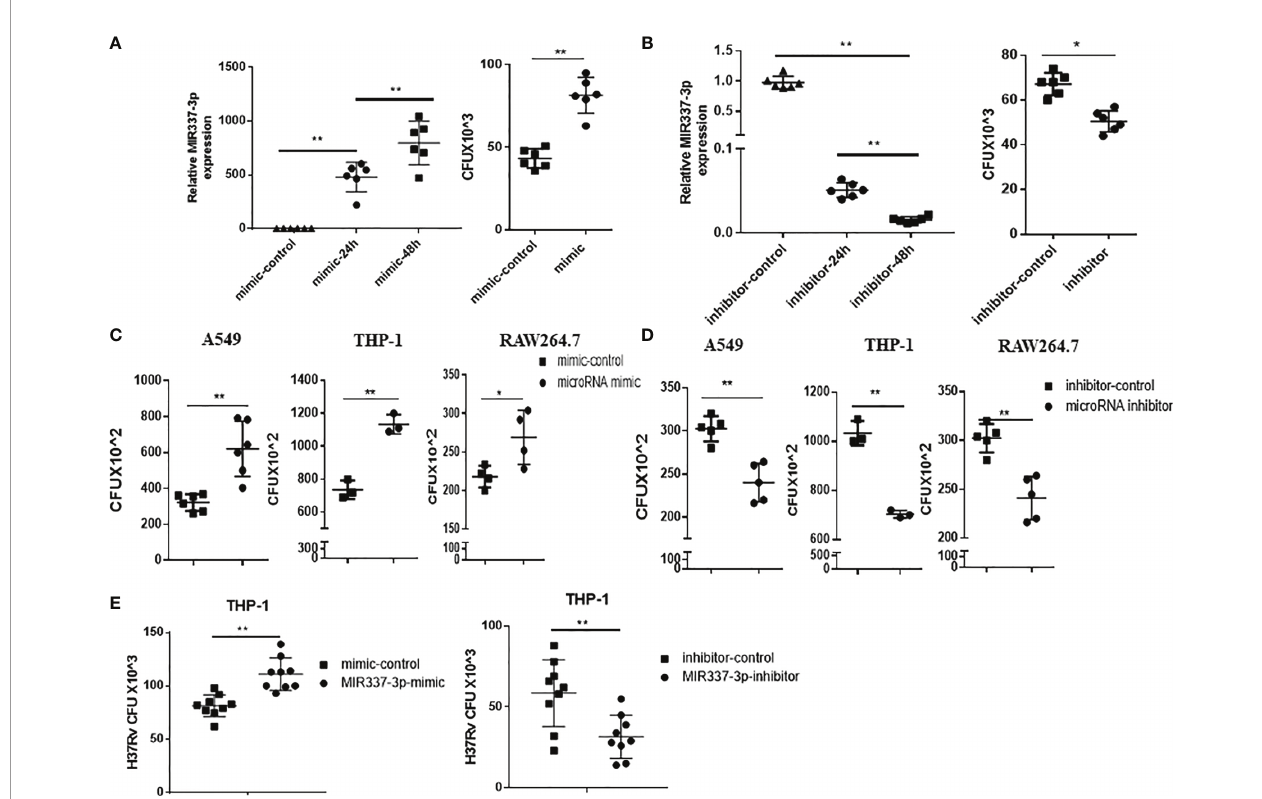
FIGURE 3 | MIR337-3p/Mir337-3p promoted the mycobacterial entry/infection and replication/growth in host target cells. The target cells were transfected with MIR337-3p mimics or inhibitors and their controls, respectively, and cocultured with BCG for 4 h or 3 days and then lysed and grown in plates to count BCG CFUs. (A) shows that MIR337-3p expression was markedly increased in THP-1 cells transfected with MIR337-3p mimics compared to the controls at 24 and 48 h after transfection (left panel), and the BCG CFU counts in the 24-h mimic-transfected THP-1 cells were signi fi cantly higher than those in the mimic control-transfected cells after 4-h BCG coculture (right panel). (B) shows that inhibitor transfection decreased MIR337-3p expression at 24 and 48 h after transfection (left panel) and also decreased the BCG CFU counts in 24-h inhibitor-transfected cells after 4-h BCG coculture (right panel). (C, D) show BCG CFU counts in A549, THP-1, and RAW264.7 cells 24 h-transfected with MIR337-3p/Mir337-3p mimics/controls and inhibitors/controls, respectively, at 3 days of culture after 4-h-BCG incubation. (E) shows virulent H37Rv CFU counts in THP-1 cells transfected with MIR337-3p mimics/controls or inhibitors/controls, respectively, at 3 days of culture after H37Rv infection. *P < 0.05 and **P <